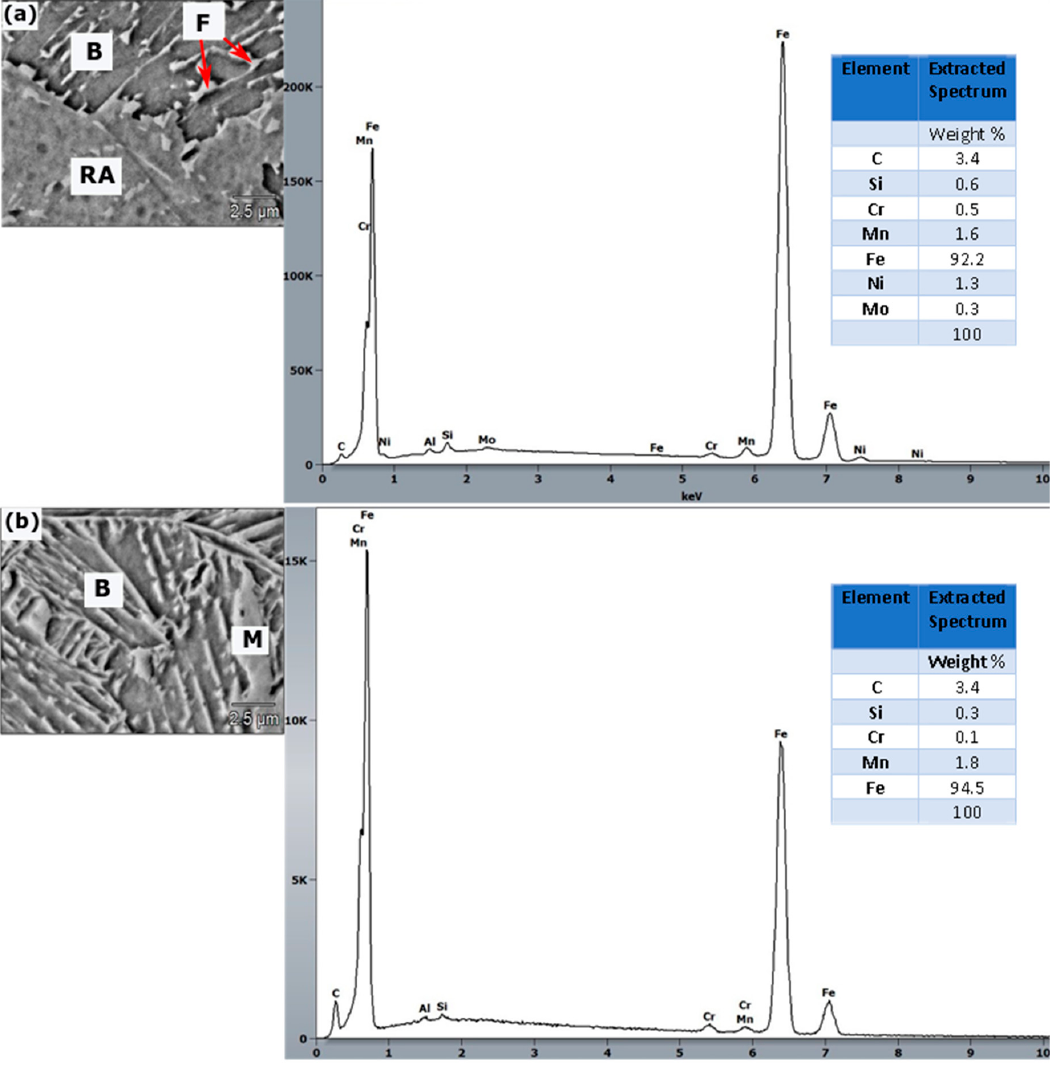
Figure 12. EDS analysis and elemental composition mapping: ( a ) S700MC and ( b ) S960QC.